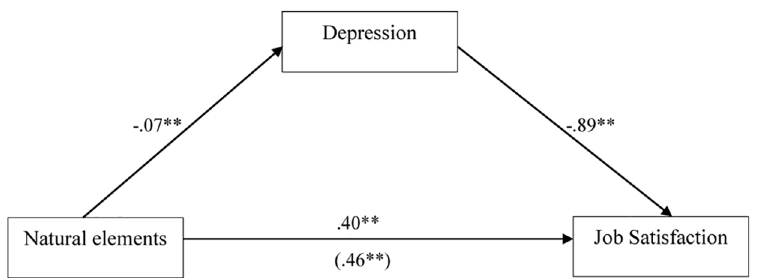
Fig 1. Mediating effects of depression between natural elements and job satisfaction. Values indicate the standardized regression coefficients taking into account the effects of control variables. A value in parenthesis indicate the bivariate coefficient between natural elements and job